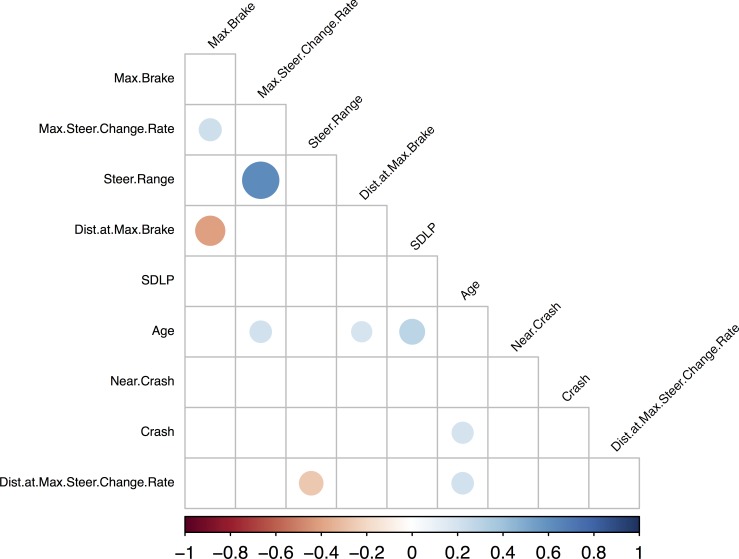
Graphical representation of the hcluster correlation analysis computed in R on the ‘Rural Scenario’ dataset controlling for mean speed.Only the significant correlations (p< .05) appear on this graphical representation.